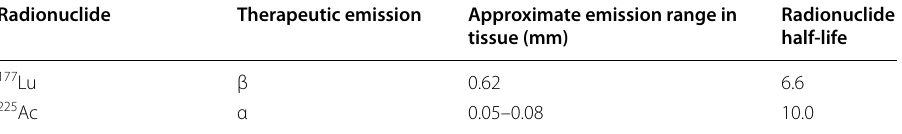
Table 1 Radionuclide properties